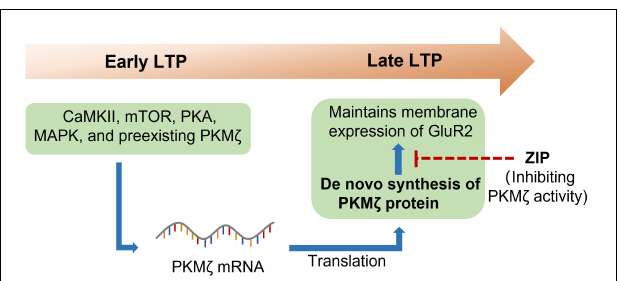
FIGURE 1 | PKM ζ maintains long-term potentiation. Long-term potentiation (LTP), once triggered, could last for hours or even weeks. Many protein kinases such as CaMKII, mTOR, PKA, MAPK, and preexisting PKM ζ are required for the early LTP. Reactivation of these protein kinases then induced translation of PKM ζ from the mRNA. The newly synthesized PKM ζ then maintains the membrane expression of GluR2, which is essential for the maintenance of LTP. CaMKII, calcium/calmodulin-dependent protein kinase II; GluR2, ionotropic glutamate receptor AMPA type subunit 2; MAPK, mitogen-activated protein kinase; mTOR, mammalian target of rapamycin; PKA, protein kinase A; PKM ζ , protein kinase M ζ ; ZIP, ζ -inhibitory